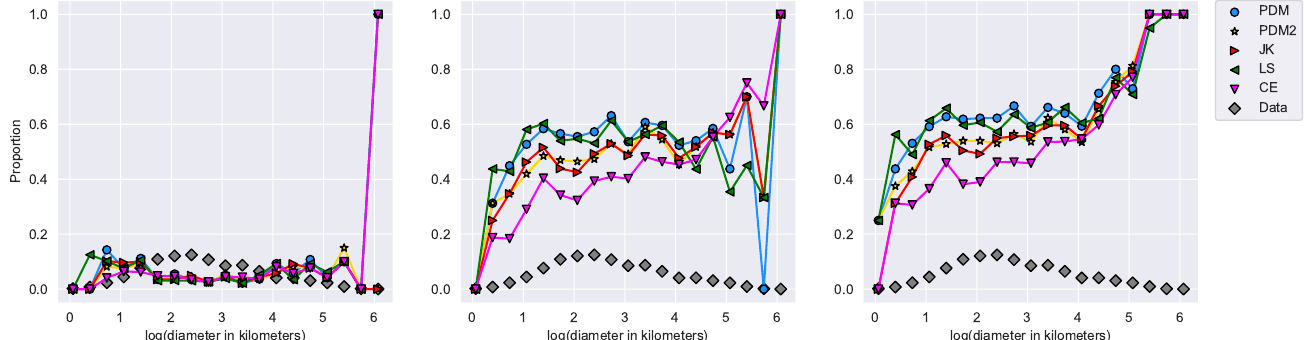
Figure 9. The comparison of different period finding algorithms considering the different diameters for the step size defined in Equation (3) with A = 10. The criterion for comparison is the proportion of asteroids having a successful periodic recovery. From left to right, the three plots are for different δφ max = 85/50,850/50 and 8500/50. The gray diamonds indicate the proportion of asteroids at the corresponding diameter in our data